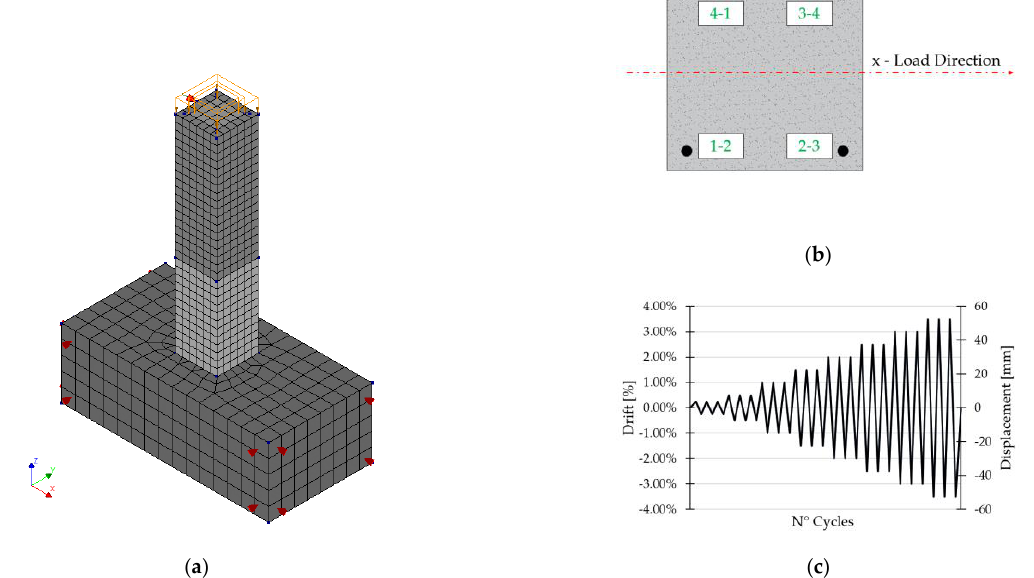
Figure 4. ( a ) Numerical model, ( b ) Column base cross-section and corroded bars casting position, ( c ) Displacement history adopted in the non-linear analyses.